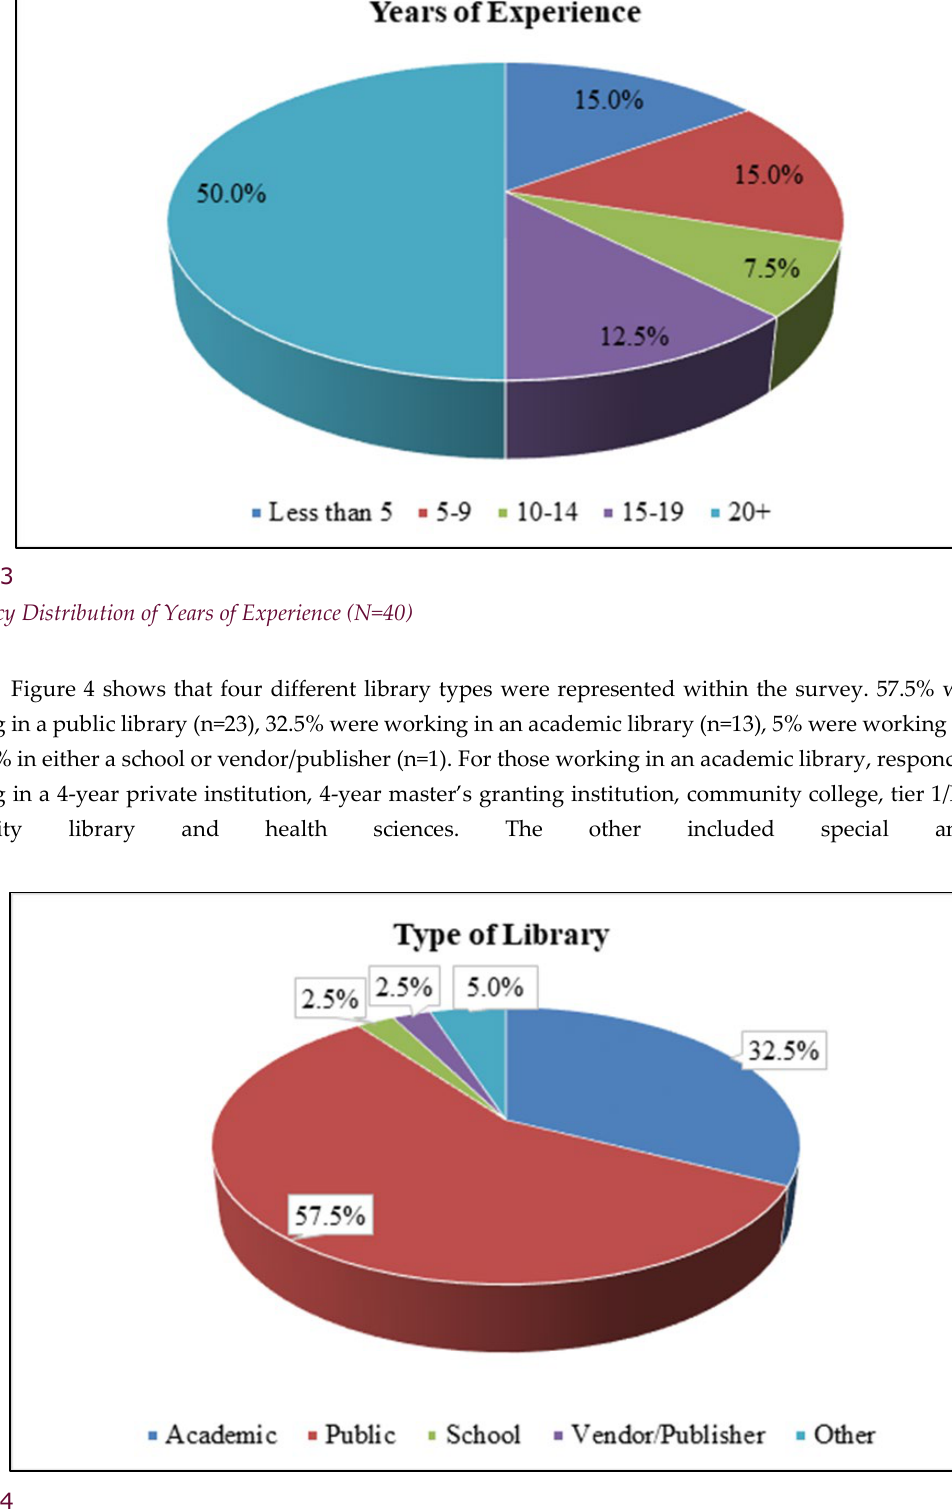
Figure 4 Frequency Distribution of Type of Library Currently Worked In